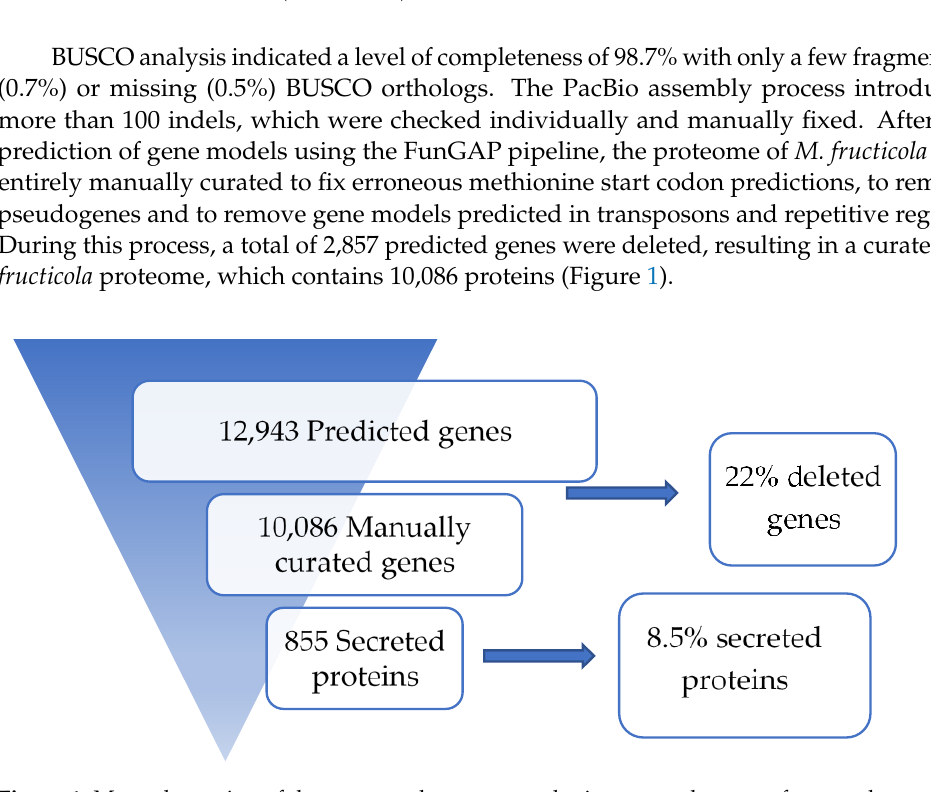
Figure 1. Manual curation of the annotated genome to obtain a trusted group of secreted proteins.